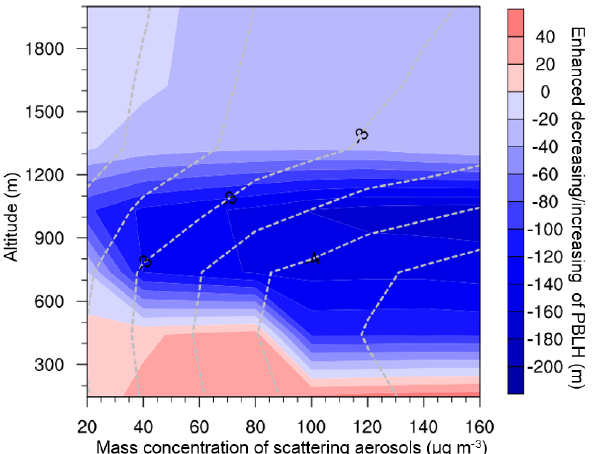
Figure 7. Enhanced decreasing/increasing of PBL height (con- tour map) and enhanced reduction of sensible heat flux at sur- face (dashed isoline) caused by amplified absorption of BC inter- nally mixed with scattering aerosols. BC concentration is fixed at 5µgm − 3 , and the ratio of scattering aerosol components is SO 2 − : NH + = 3 : 2 : 1, which is based on year-round observations NO − 3 4 in Beijing (Zhang et al., 2012). The x and y axes are the same as Fig.